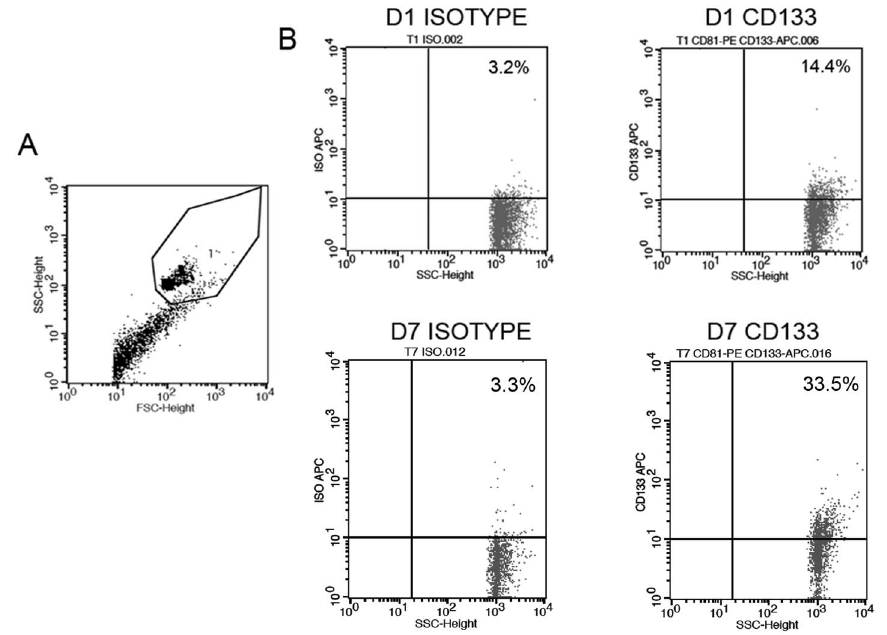
Figure 5. Detection of CD133 + EVs in transplanted patients. Panel A and B. Representative dot plots showing the gating strategy of latex bead-conjugated EVs (A) and the fluorescence detection of isotype or CD133 on EVs from a transplanted patients at day 1 or 7.